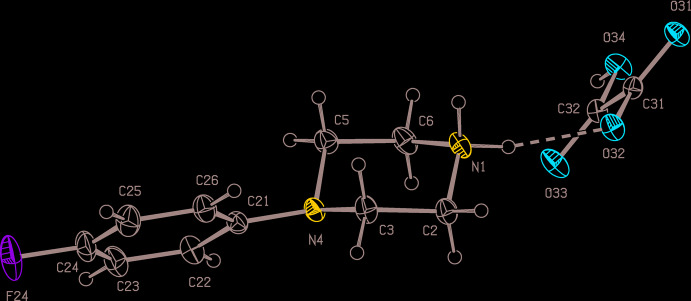
The independent components of compound (II) showing the atom-labelling scheme and the hydrogen bonds (drawn as dashed lines) within the asymmetric unit. Displacement ellipsoids are drawn at the 30% probability level.